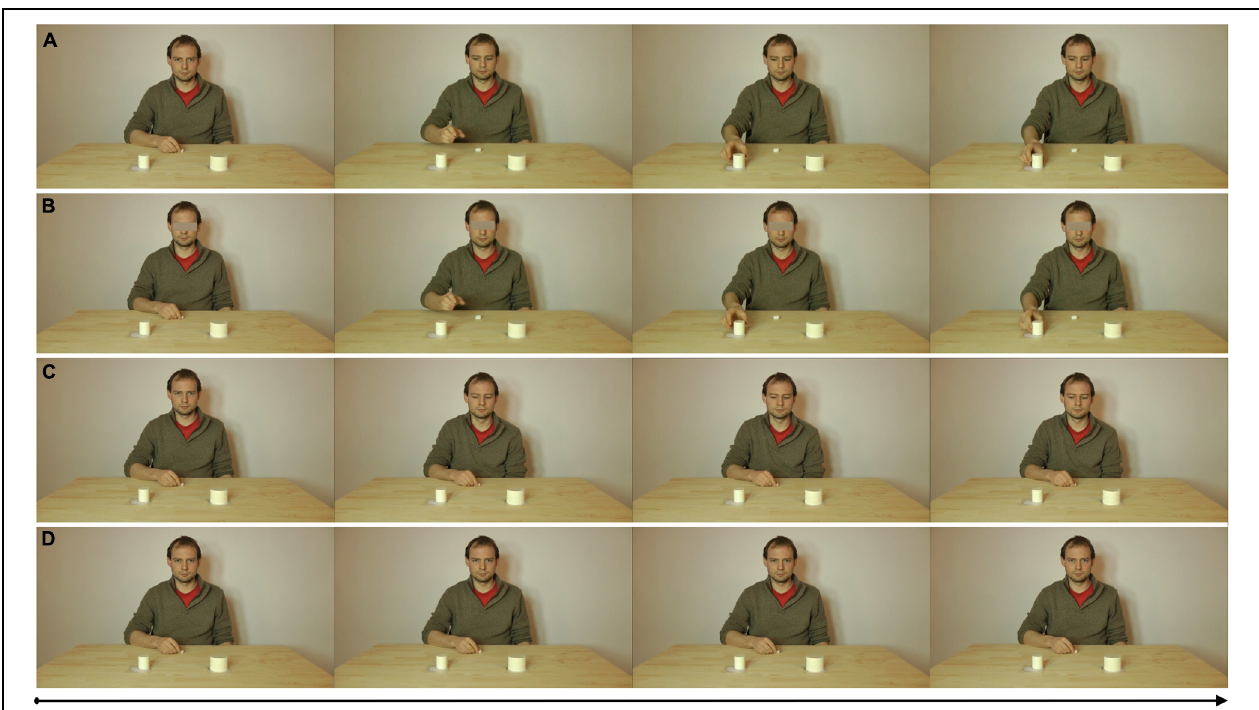
FIGURE 2 | Examples of observation video clips from each experimental condition. From top to bottom: conditions (A) FULL, (B) ACTION, (C) GAZE and (D) CONTROL. The videos were presented on a HD screen (1920 ∗ 1080 pixel). The actor’s eyes area